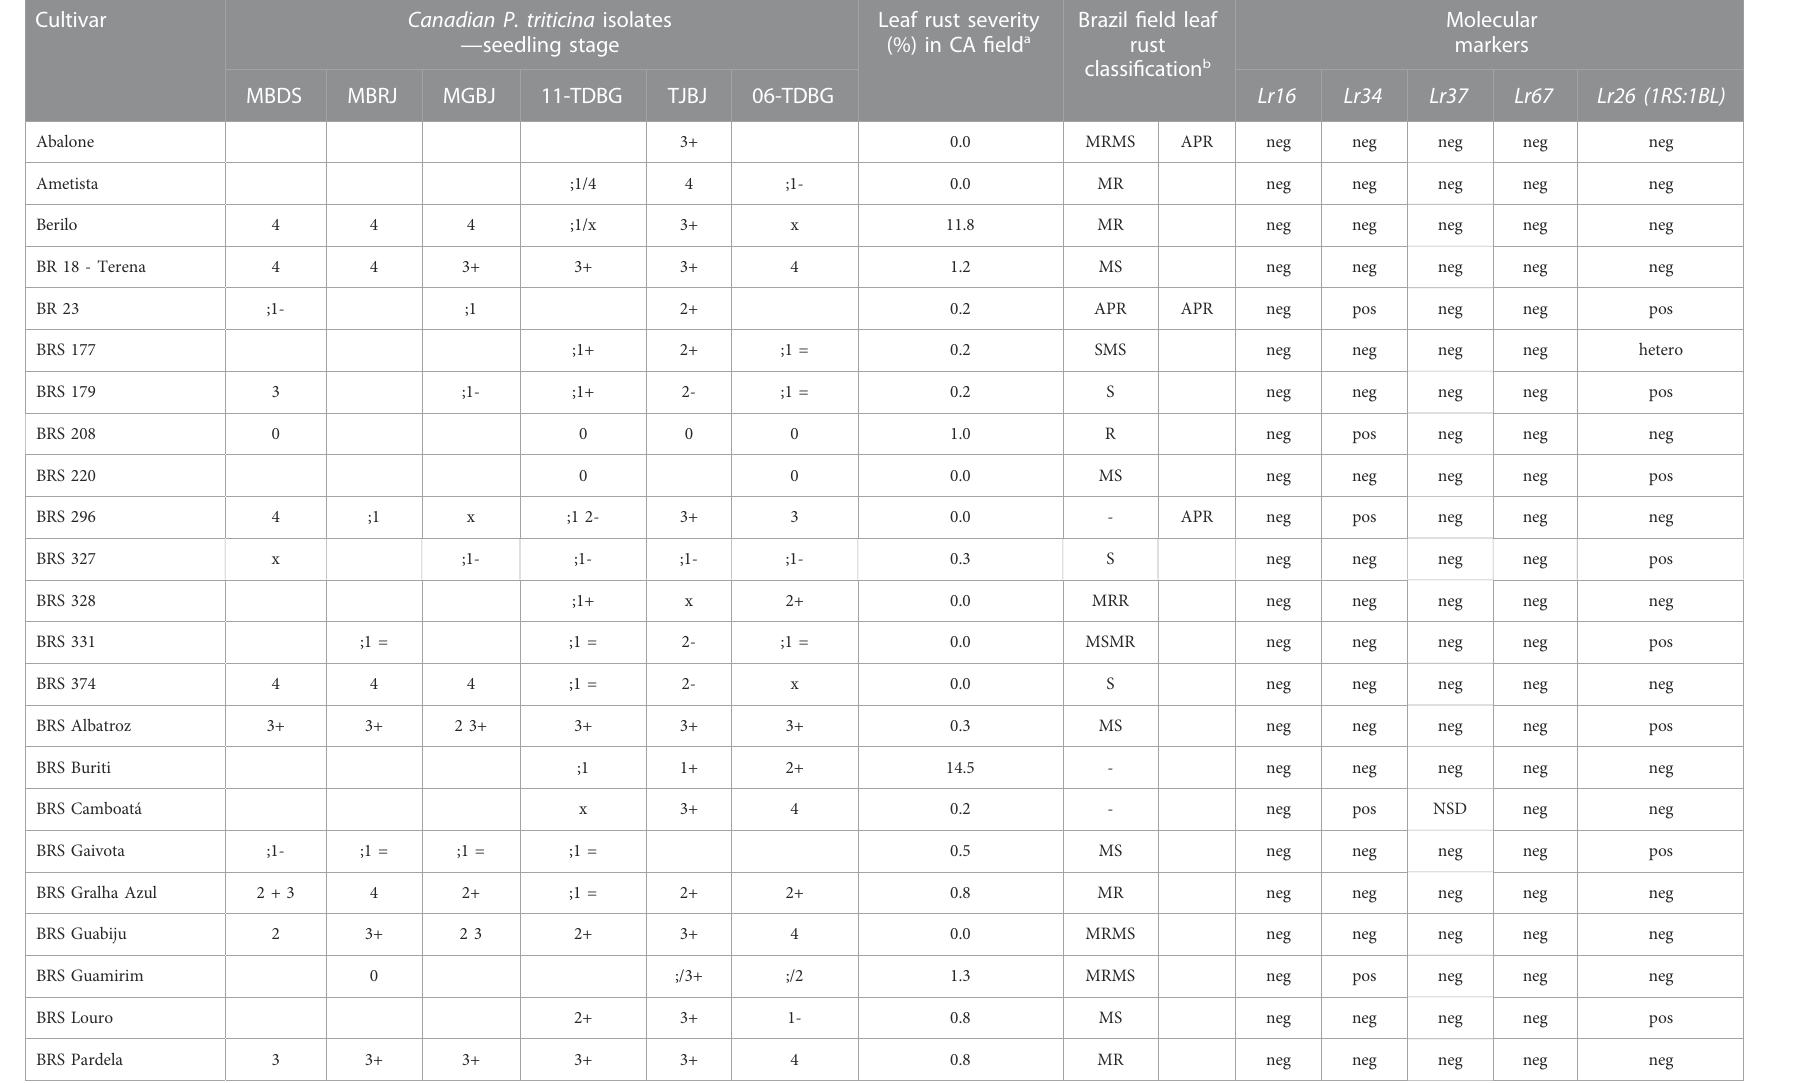
TABLE 3 Characterization of the Brazilian collections to leaf rust ( Puccinia triticina ). Reaction at seedling stage of Brazilian wheat cultivars to Canadian leaf rust isolates, comparison of resistance reaction between Canada and Brazil (Dotto et al., 2005; Informações técnicas para trigo e triticale - Safra, 2012, 2011; Cunha and Caierão, 2014; Cunha et al., 2016; Silva et al., 2017; Franco and Evangelista, 2018; Informações técnicas para trigo e triticale - Safra, 2019, 2018; Informações técnicas para trigo e triticale - Safra, 2020, 2020; Informações técnicas para trigo e triticale - Safra, 2022, 2022). Prediction of the resistance genes in the collection by genotypage of genes/loci relatedwithleafrustresistance.APR:adult plantresistance determined phenotypically bycomparing seedling andadult plantresistance (noindication ofAPRpresence inthetabledoesnotmeannecessarily absence ofAPR); pos: positive allele, presence of the resistant allele; neg: negative, presence of the susceptible allele; hetero: heterozygosity in the locus; NSD: not suf fi cient